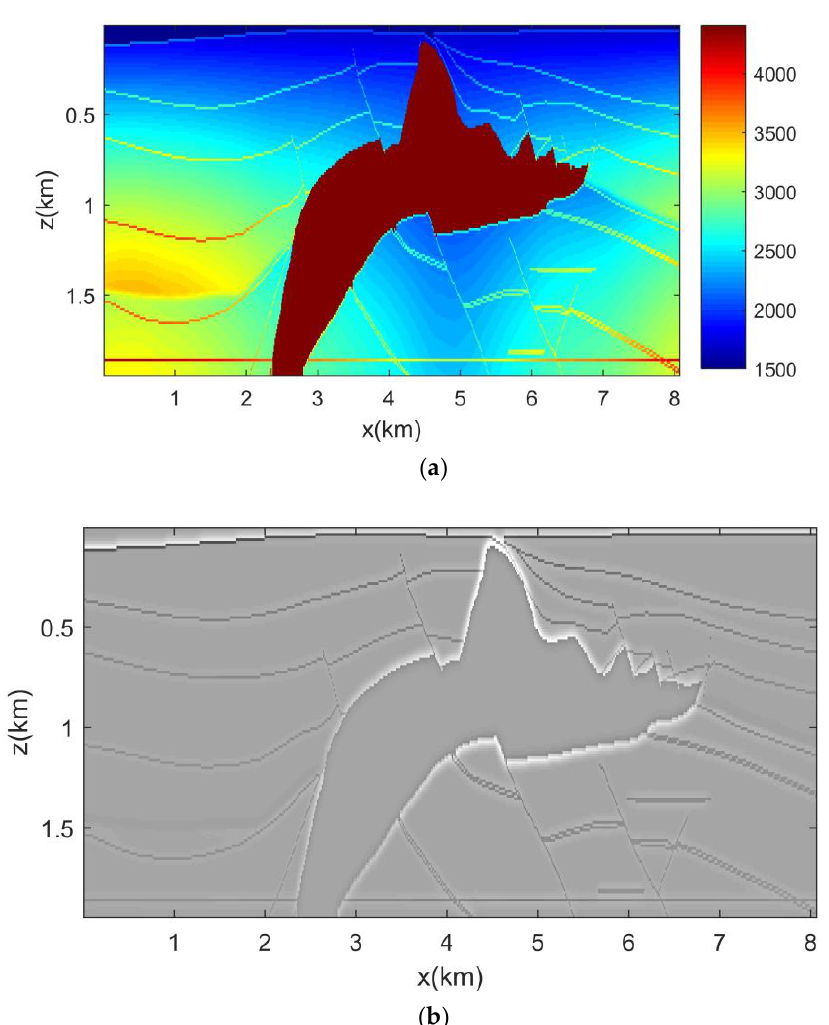
Figure 6. ( a ) True velocity model. ( b ) True reflectivity model.